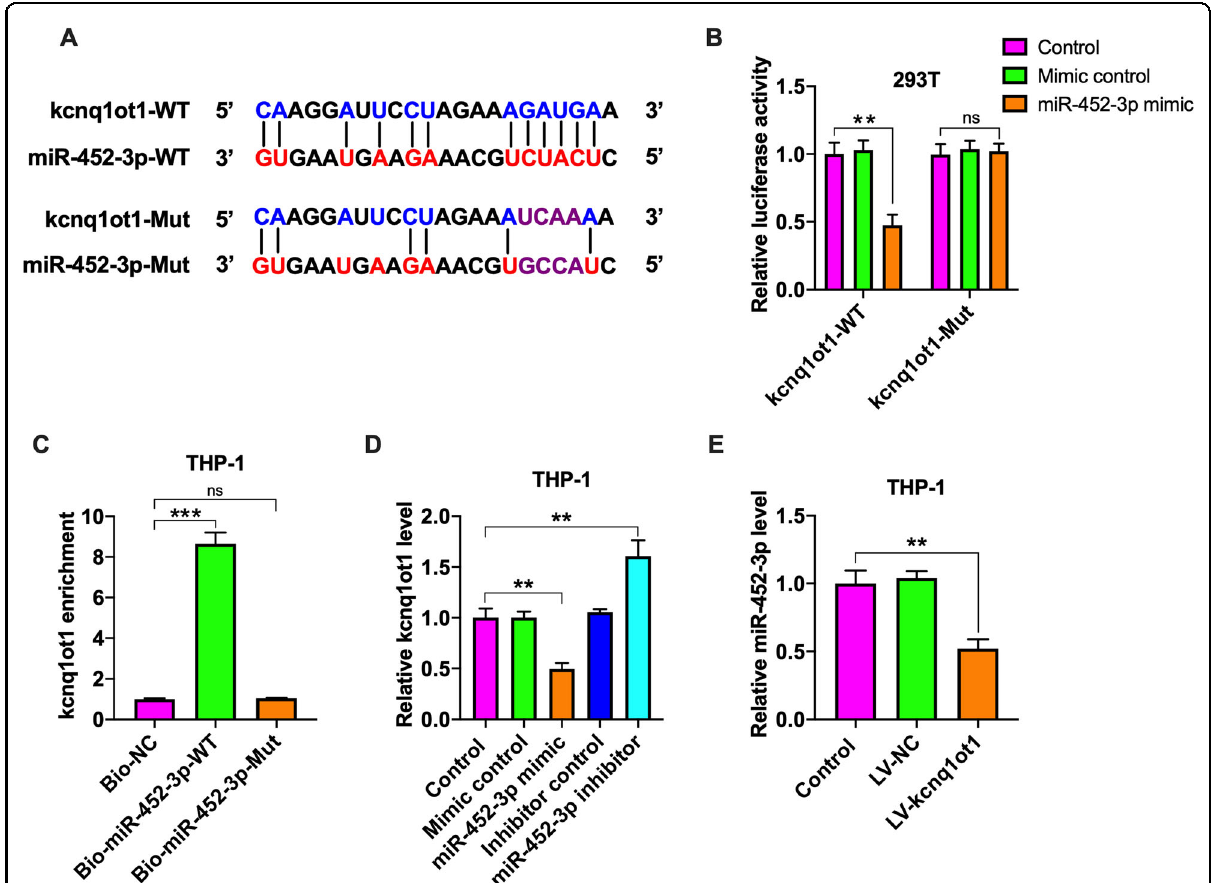
Fig. 7 Validation of kcnq1ot1 as a ceRNA for miR-452-3p. A Schematic representation of miR-452-3p binding site in the kcnq1ot1 sequence and corresponding mutation. B The luciferase reporter plasmids kcnq1ot1-WT or kcnq1ot1-Mut were co-transfected into 293T cells with miR-452-3p mimic or its negative control for 48 h, followed by detection of luciferase activity. C THP-1 macrophages were transfected with bio-NC, bio-miR-452- 3p-WT or bio-miR-452-3p-Mut for 48 h, which was followed by pull-down assay. D THP-1 macrophages were incubated with miR-452-3p mimic/ inhibitor or their negative controls for 48 h. The expression of kcnq1ot1 was evaluated by qRT-PCR. E Following transduction of THP-1 macrophages with PBS, LV-NC, or LV-kcnq1ot1 for 72 h, qRT-PCR was conducted to detect miR-452-3p expression. Data are represented as mean ± SD from three independent experiments. ** P < 0.01, *** P < 0.001; ns not signi fi